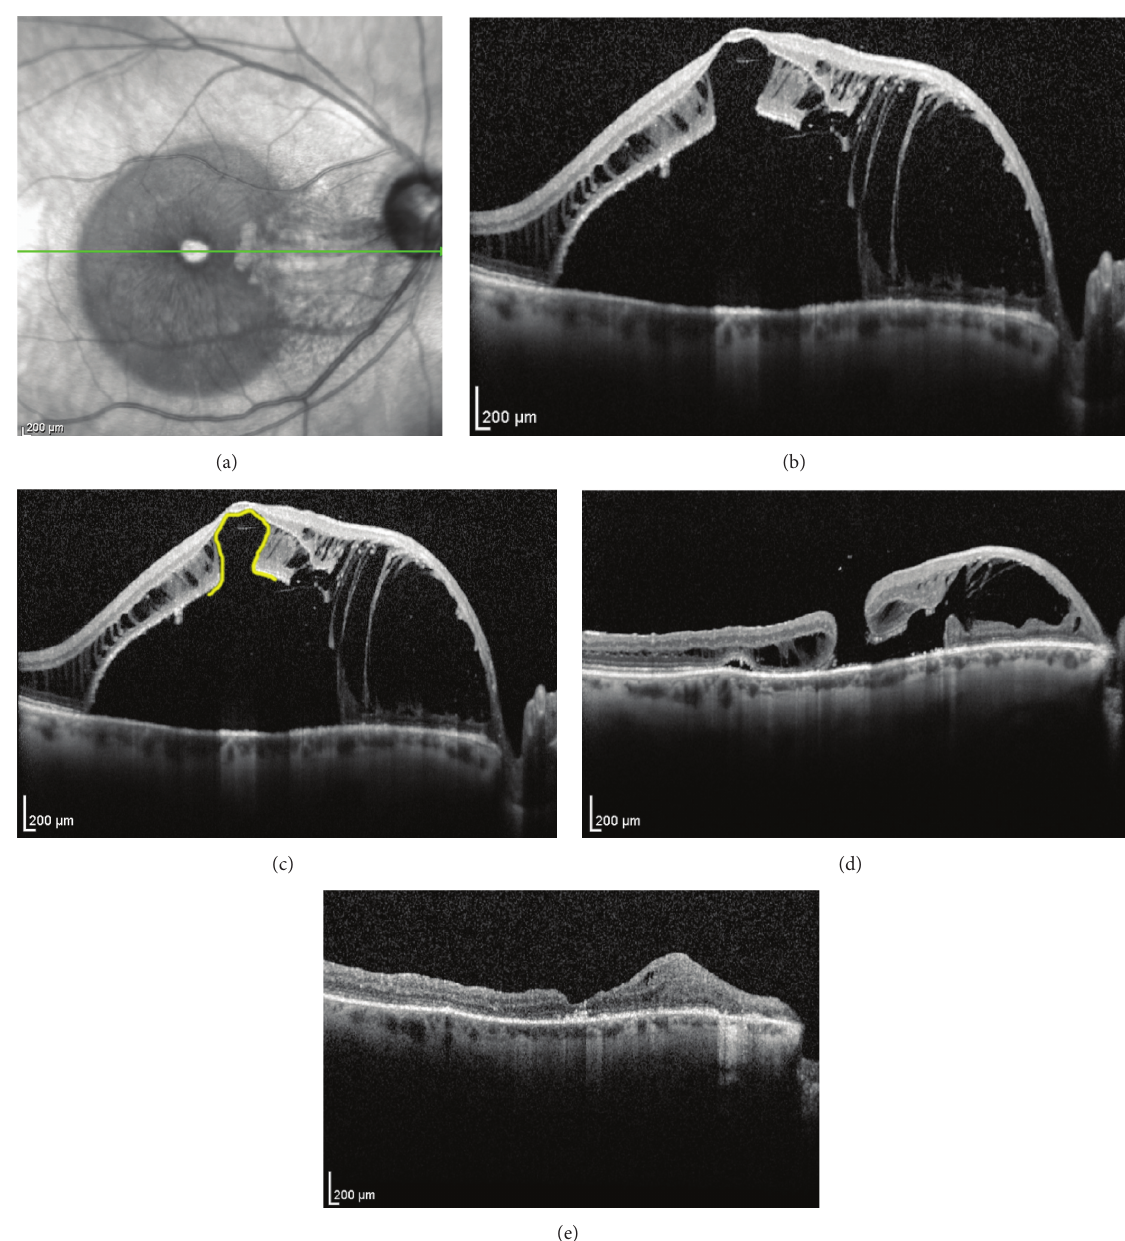
Figure 2: (a) Infrared reference image and (b) foveal SDOCT raster scan of the right macula. Infrared imaging showed hyperintensity within areas of nasal macular schisis within Henle’s layer and hypointensity in areas temporally with serous retinal detachment. The foveal center appears hyperintense from transmission defect. Schisis involved the photoreceptor and outer plexiform layers with intact nerve fiber layer. (c) Lateral displacement of the photoreceptors produced the “omega sign” on SDOCT, highlighted in yellow, indicating that only the M¨uller cell cone was bridging the foveola. (d) SDOCT foveal raster scan six weeks after PPV with ILM peeling shows FTMH 5 contiguous with resolving schisis cavity nasally. (e) One year later, after silicone oil was removed, the FTMH remained closed; schisis had resolved. Thinning and disorganization linger among layers previously affected by severe